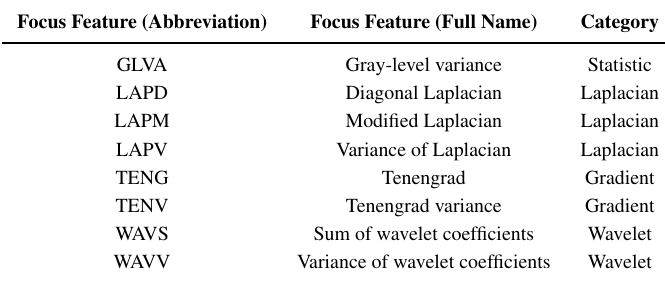
Table A1. Focus features.